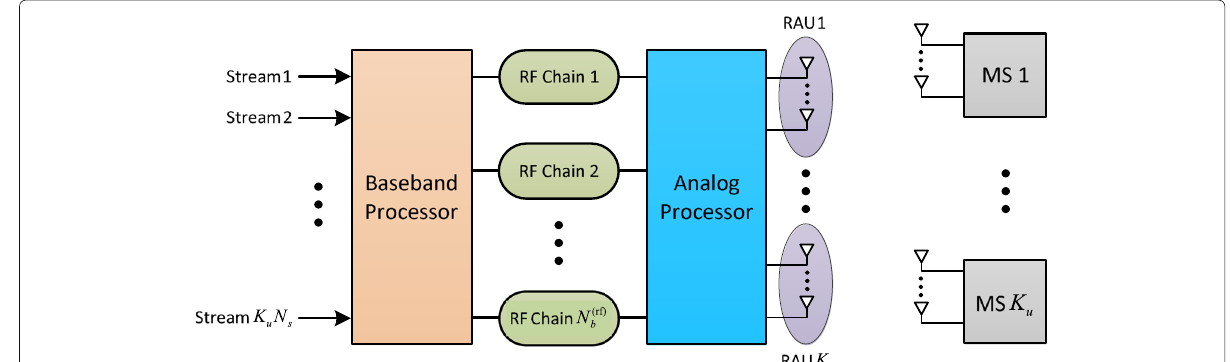
Fig. 4 Block diagram of a multiuser mmWave system with distributed antenna